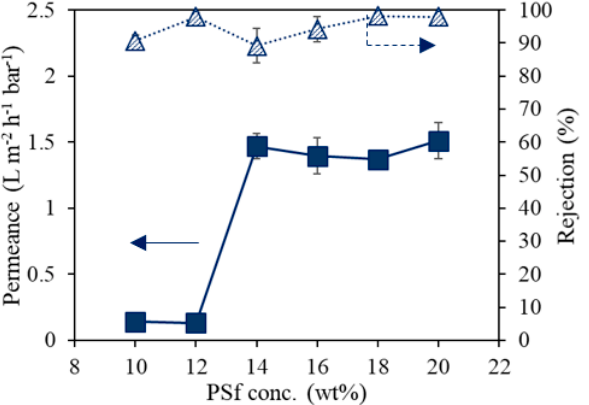
Figure 8. Water permeance and RB rejection of PA TFC membranes synthesized on UV-cured PSf supports with 2 wt% cross-linker, 0.3 wt% photo-initiator, and various initial PSf concentrations.